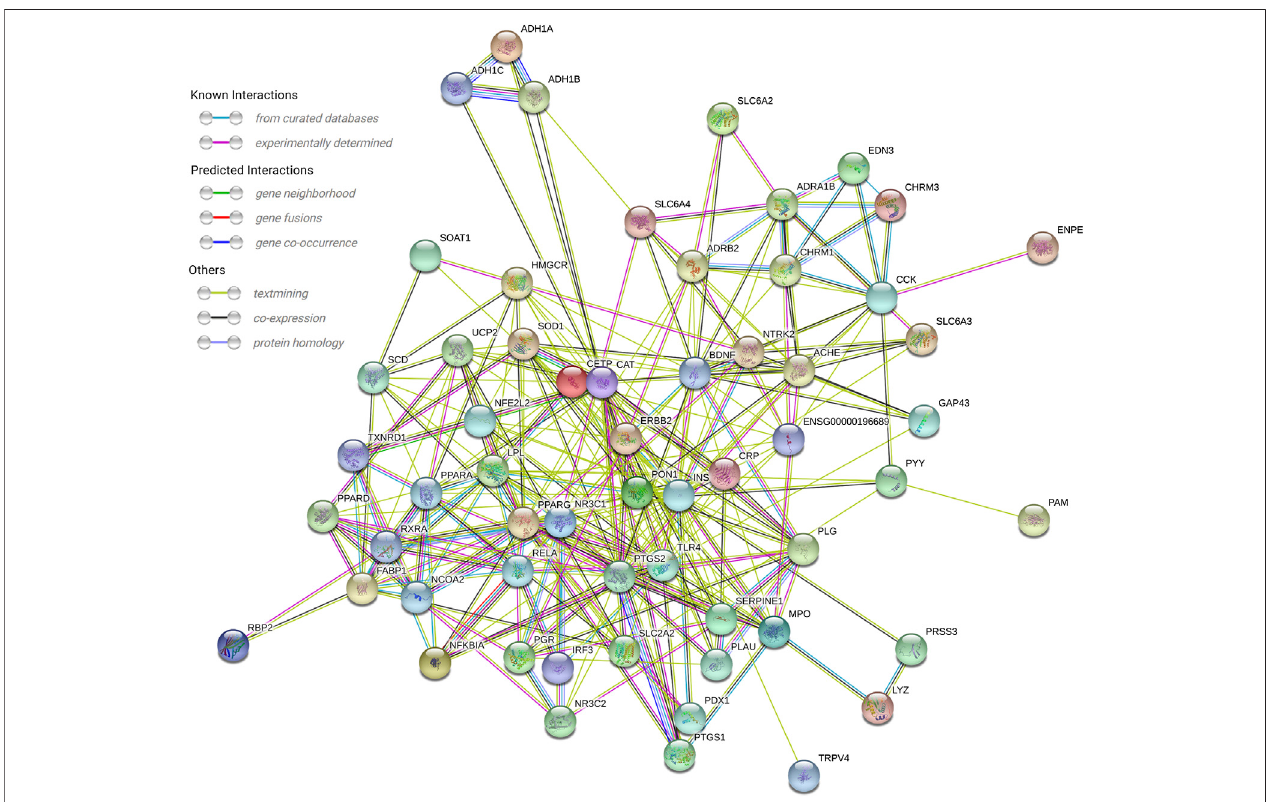
FIGURE 3 | PPI network of 59 nodes. A total of 59 overlapped target genes were used to construct the PPI network.